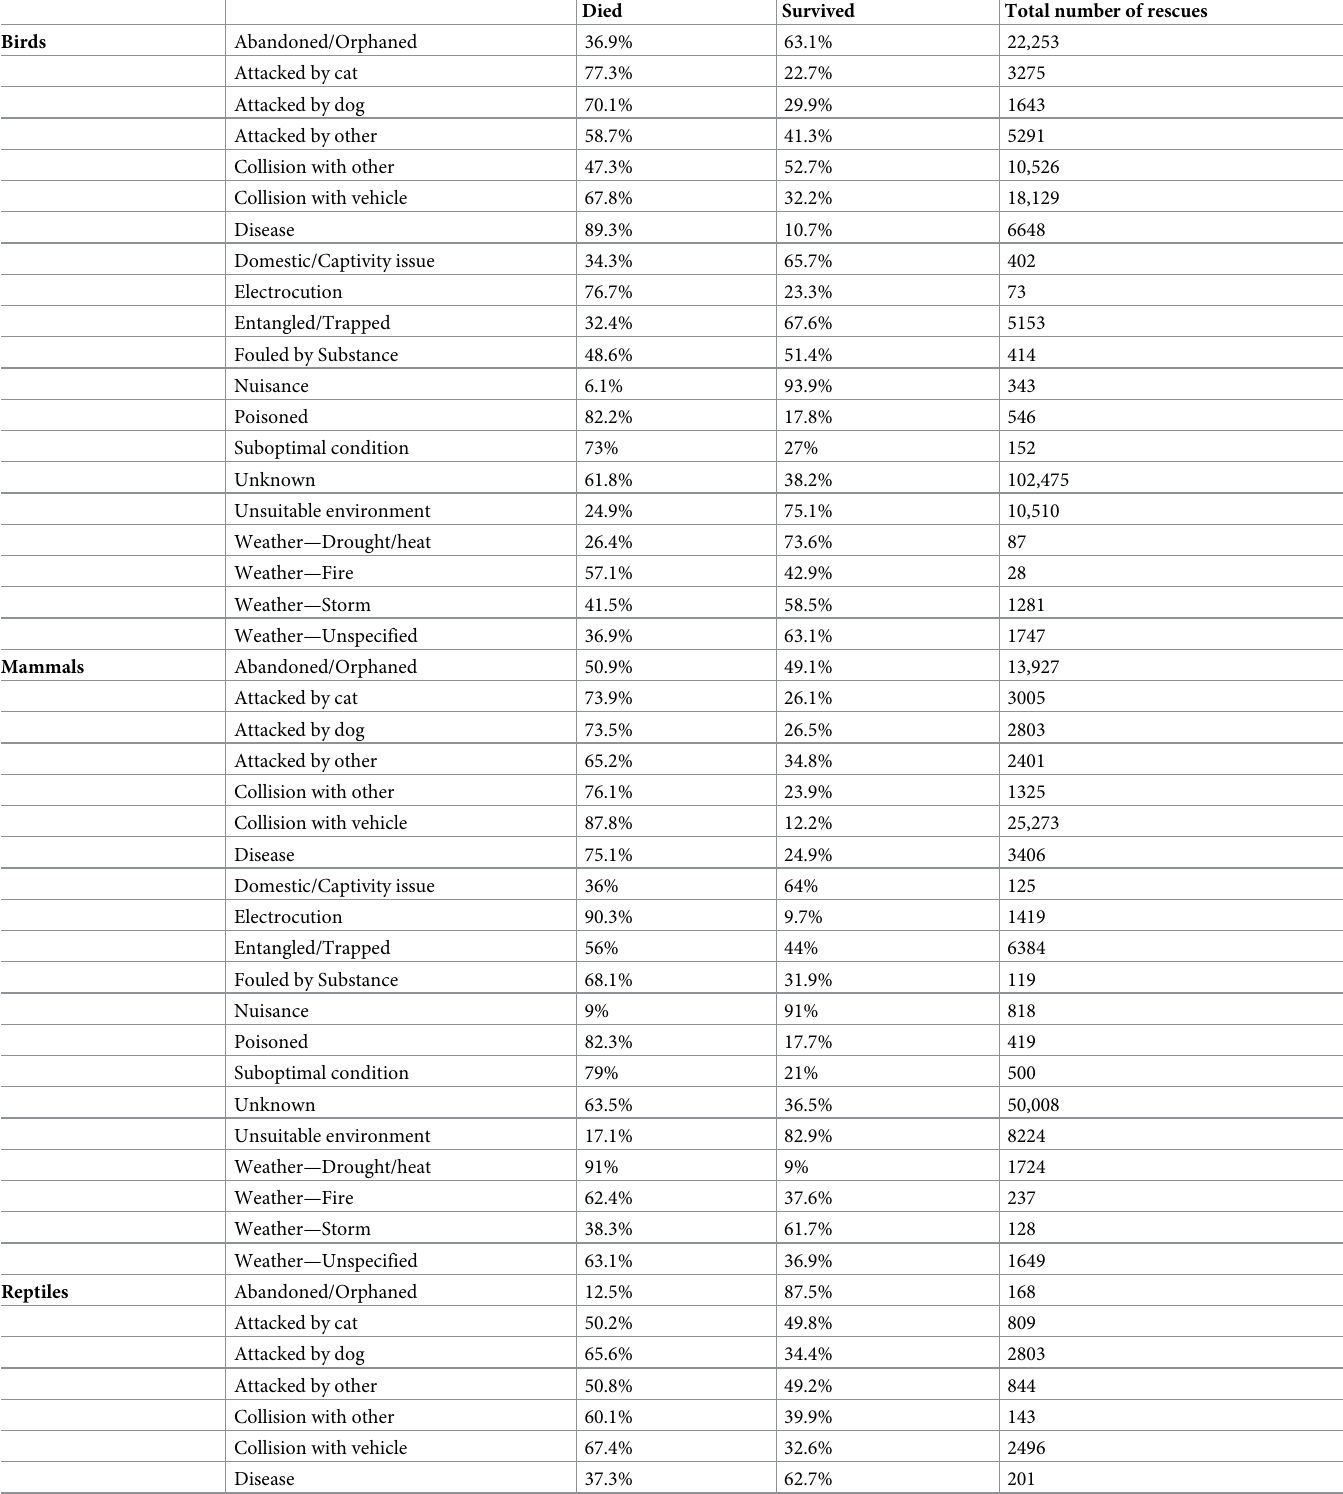
Table 10. Fate (survived or died) for each cause for rescue and each animal